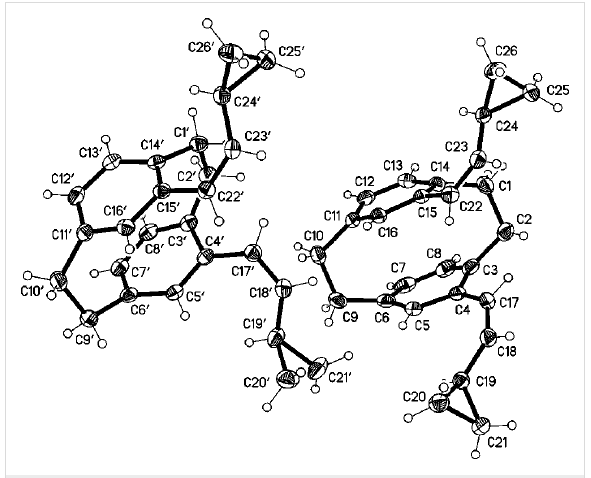
Figure 3: The two independent molecules of compound Z , Z - 22 in the crystal. Ellipsoids correspond to 50% probability levels.